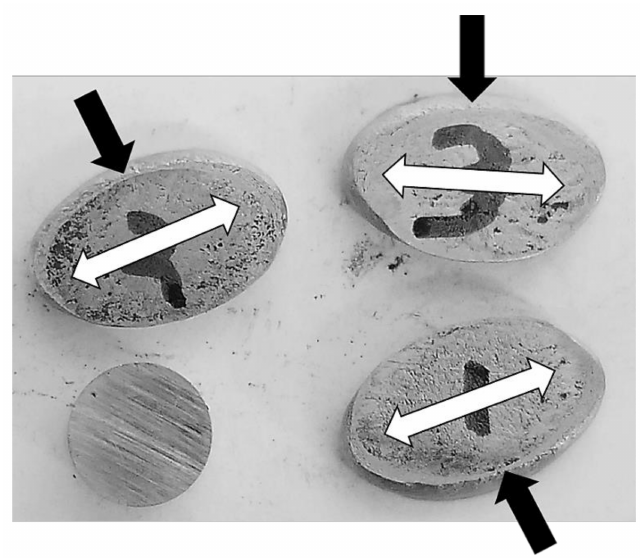
Figure 2. 0 ◦ –[100]–0 ◦ specimens after compression testing (black arrows indicate the direction of shear plastic deformation, and the white arrows indicate the maximum width). Lower left is untested specimen.